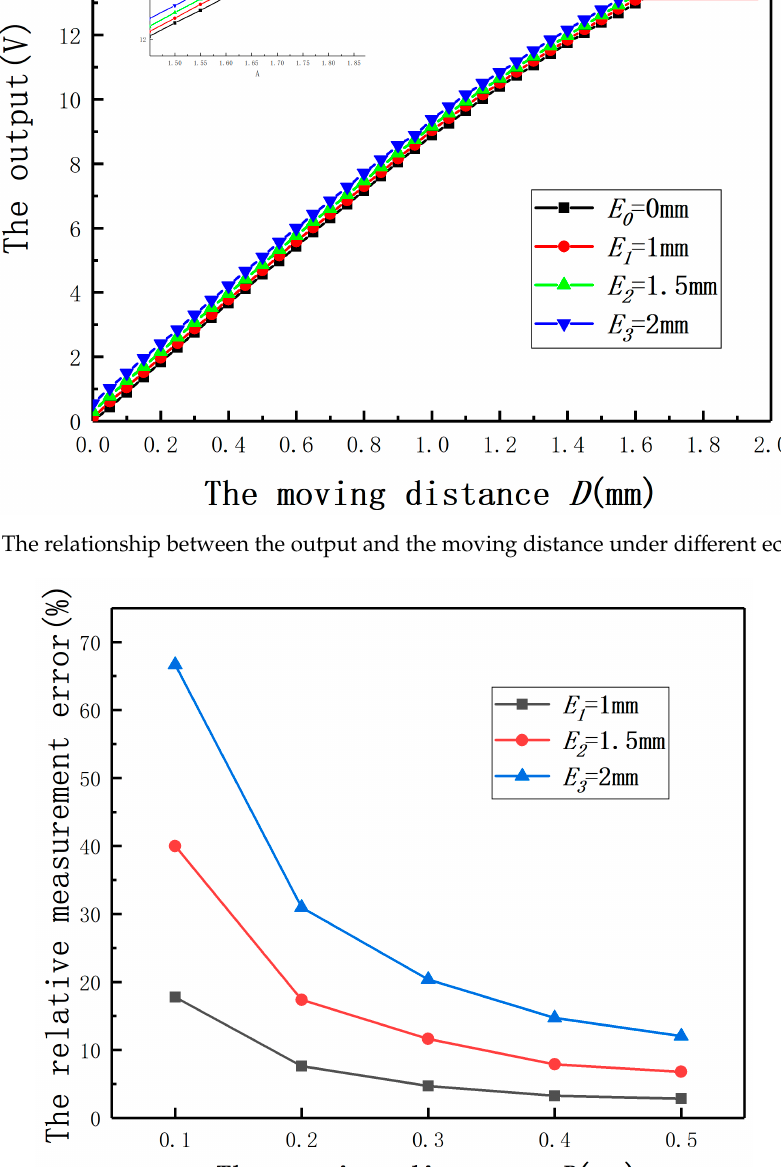
Figure 31. The relative measurement errors under different eccentricities.